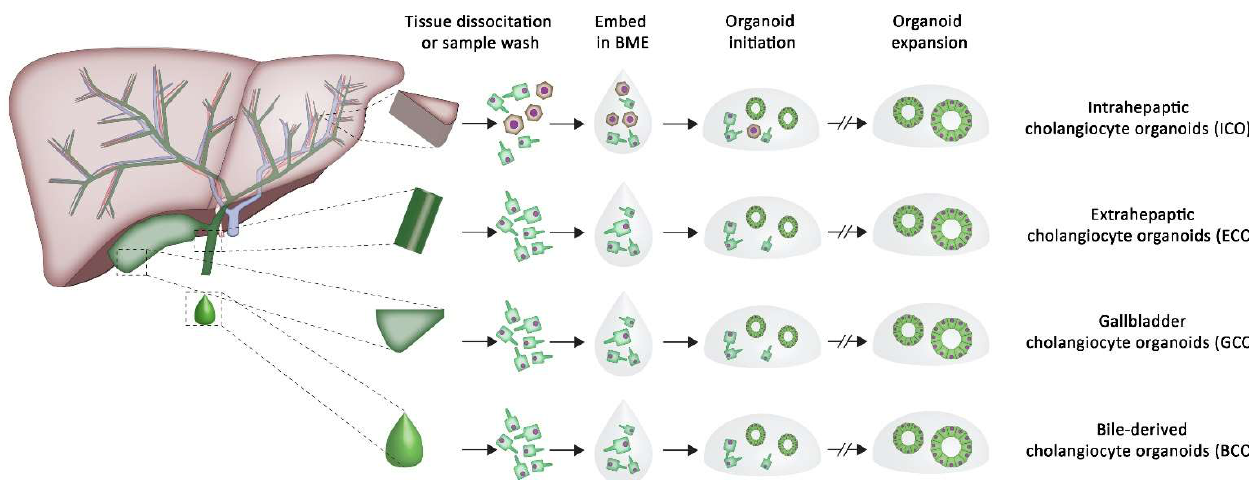
Figure 1. Schematic overview of the workup of cholangiocyte organoids in BME cultures and the different sources of organoids. Cholangiocyte organoids can be initiated from liver tissue biopsies (intrahepatic cholangiocyte organoids; ICO), extrahepatic bile duct tissue biopsies (extrahepatic cholangiocyte organoids; ECO) and gallbladder tissue biopsies (gallbladder cholangiocyte organoids; GCO). Organoids can also be initiated from bile samples (bile-derived cholangiocyte organoids; BCO). Organoids are traditionally grown and expanded in BME.